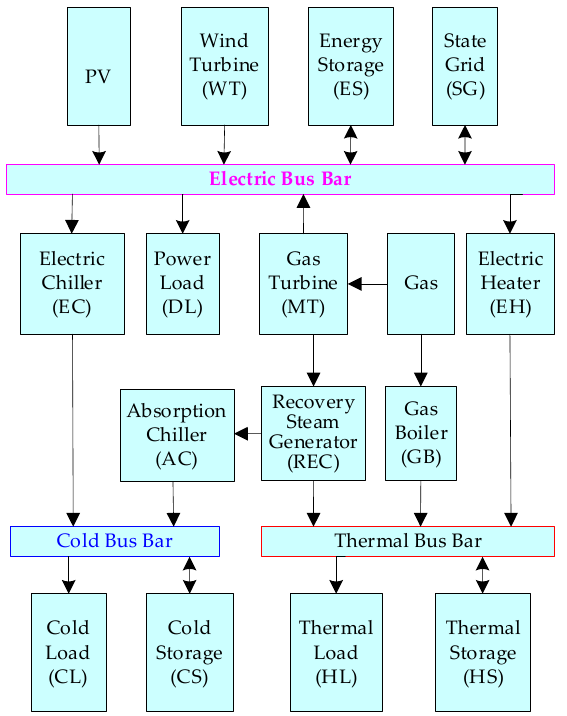
Figure 1. Structure diagram of the integrated energy system.